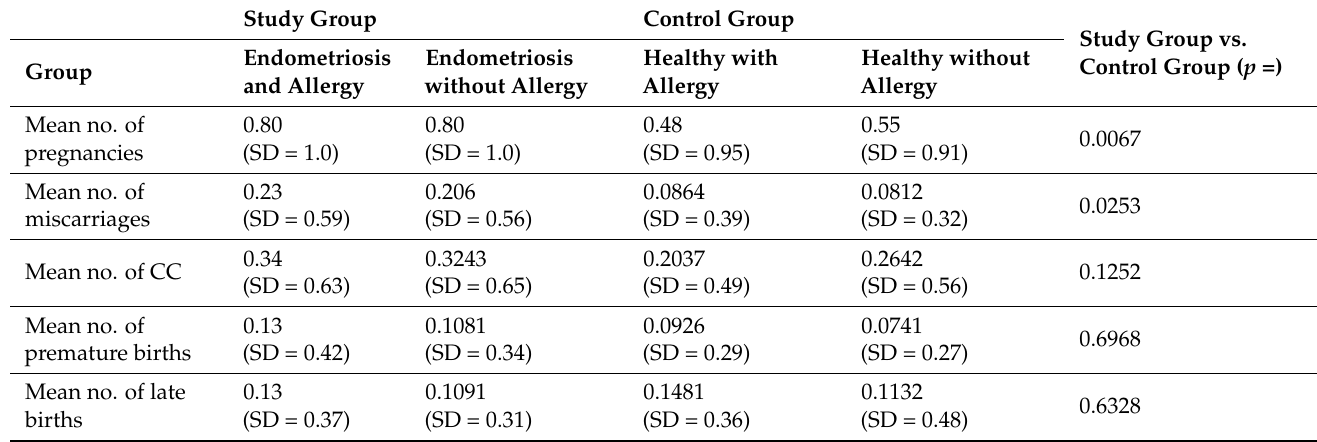
Table 1. Characteristics of the groups regarding their parity